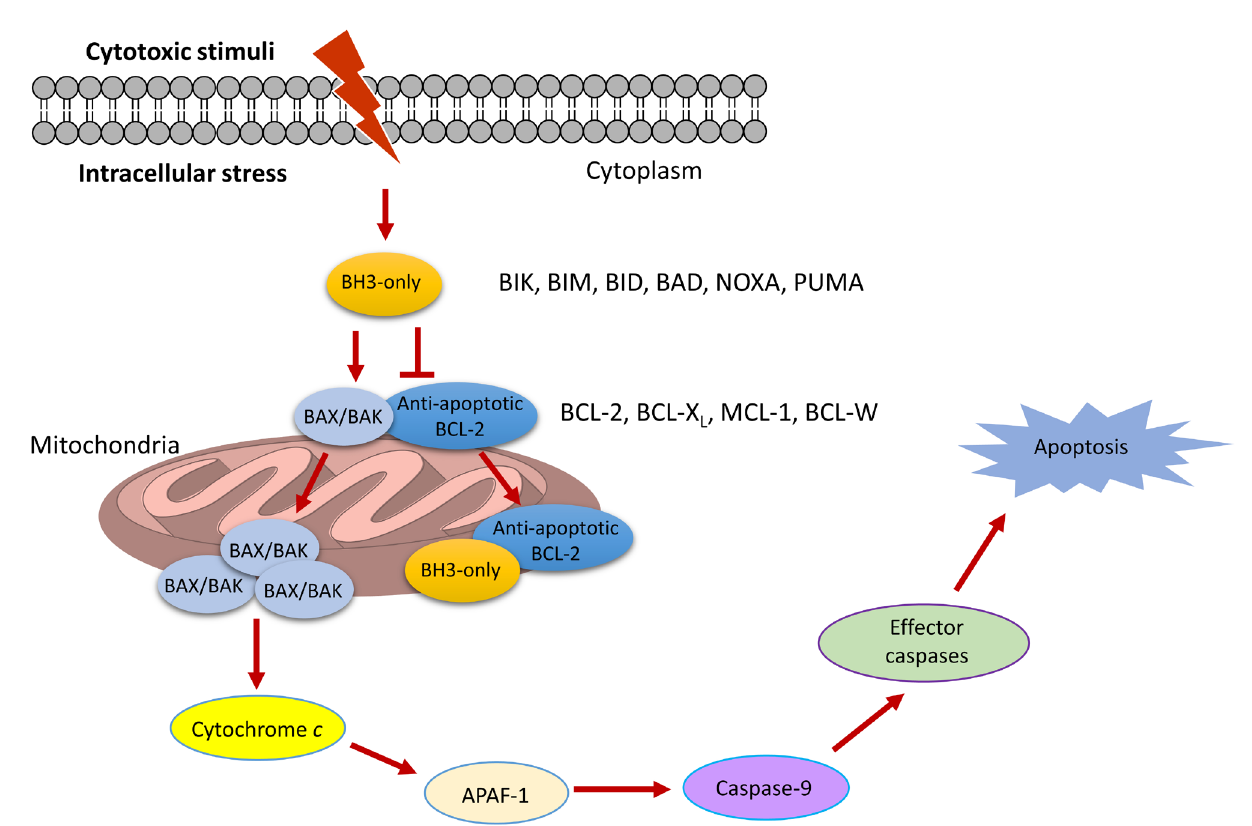
Explor Target Antitumor Ther. 2020;1:259-72 | https://doi.org/10.37349/etat.2020.00017